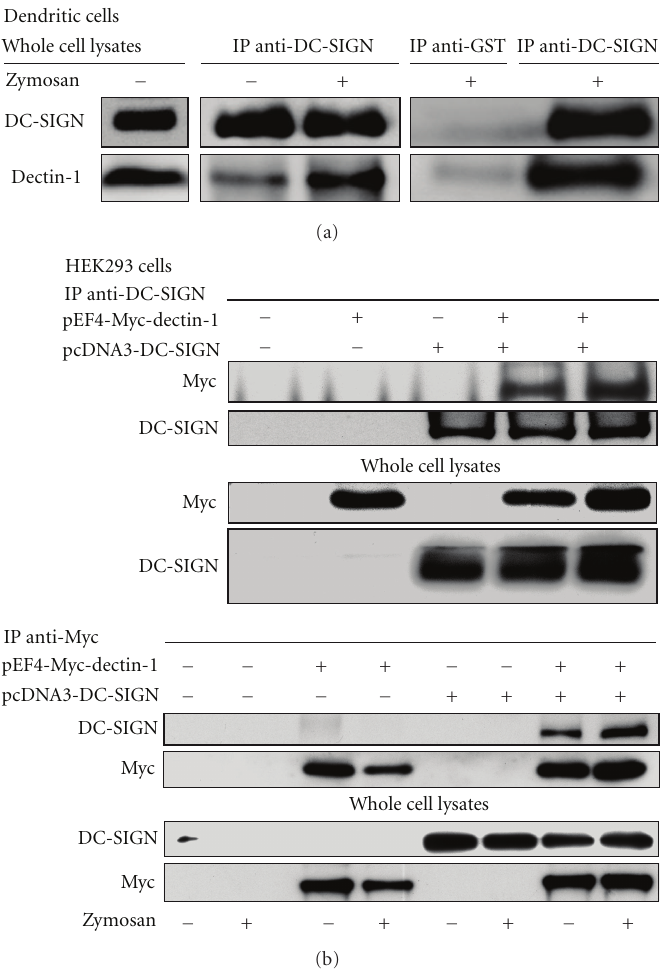
Figure 4: Coimmunoprecipitation of dectin-1 and DC-SIGN. DC were incubated in the presence and absence of 1mg/ml zymosan for 10 minutes and then the cell lysates were used for immunoprecipitation with either 5 μ g anti-DC-SIGN or 5 μ g anti-glutathione S-transferase (GST) control mAb and blotting with anti-DC-SIGN, anti-dectin-1, or anti-GST Ab (a). HEK293 cells were transfected with the indicated expression vectors and the cell lysates immunoprecipitated with either 2 μ g anti-DC-SIGN or 0.5 μ g anti-Myc mAb (b). Upper panels show the expression of the Myc tag and DC-SIGN in the immunoprecipitates. The lower panels show the expression of the proteins in the cell lysates. Cells transfected with pEF4 empty vector were used where no expression vector is indicated. Immunoprecipitations have been conducted with 2 mg protein per condition. The lanes corresponding to cell lysates were loaded with 40 μ g protein. Reproduced with permission